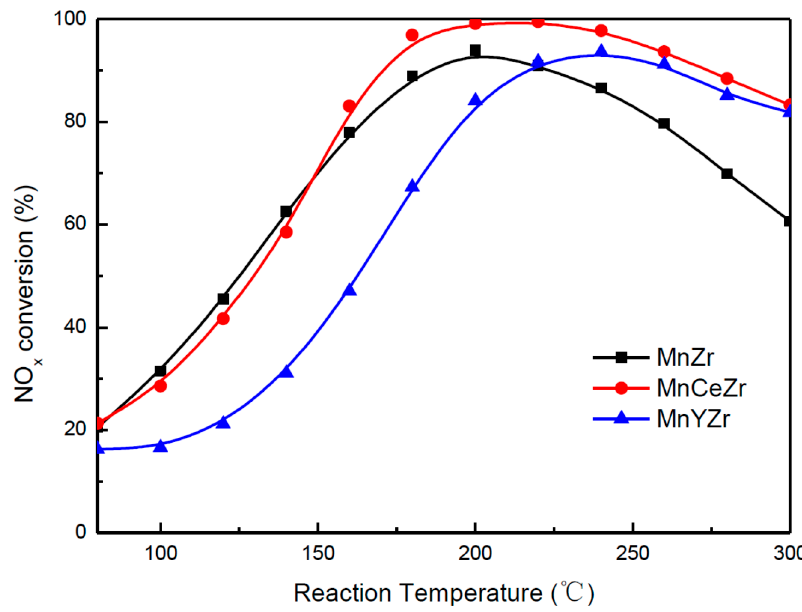
Figure 1. NO x conversion of Ce-, Y-doped MnO x /ZrO 2 /MWCNTs catalysts as a function of temperature reaction condition: 0.06% NO; 0.06% NH 3 ; 3% O 2 ; Ar balance, gas hour space velocity ( GHSV) = 40,000 h − 1 .